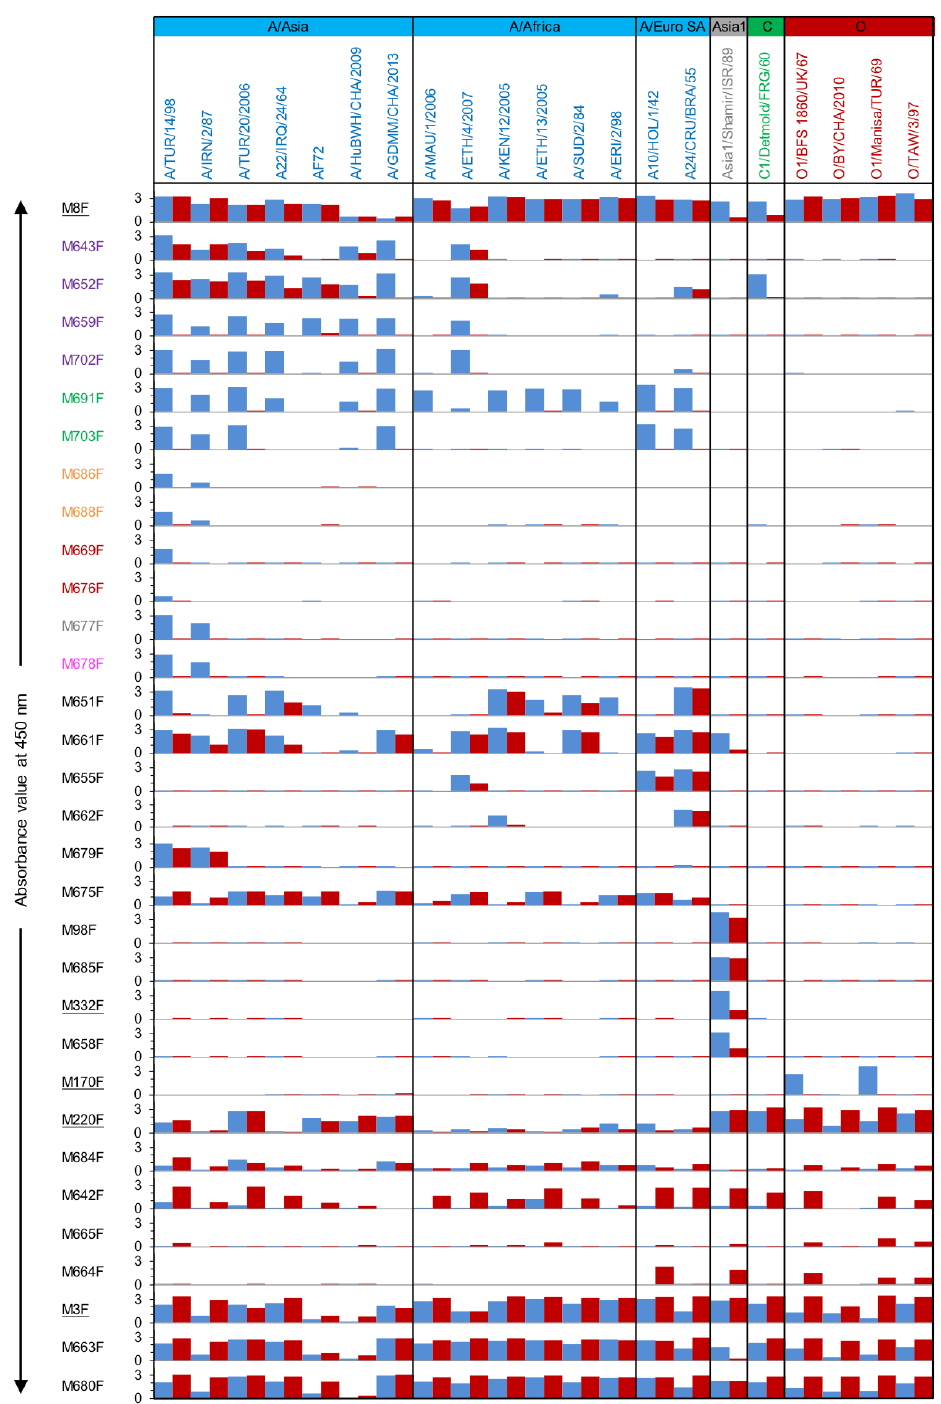
Figure 2. FMDV particle- and strain-specificity of VHHs. DAS-ELISAs were performed using a matrix of 32 VHHs and 21 FMDV strains representing four serotypes. Each strain was used in ELISA at 1 µg/mL 146S either as untreated authentic particles (blue) or after conversion into 12S by heating (red). The absorbance value at 450 nm after subtraction of the background absorbance without FMDV particles is shown. The 12 VHHs of the 6 CDR3 groups comprising the 10 VHHs that bind specifically to 146S of serotype A strains are color-coded by their CDR3 group. The control VHHs isolated earlier are underlined. The VHHs are arranged from top to bottom according to their CDR3 group and their particle and strain specificity. Broadly reactive control VHH M8F, however, is placed on top to show all FMDV particle preparations contain immunoreactive material. FMDV strains are arranged from left to right according to their phylogenetic relationship (Figure 3).